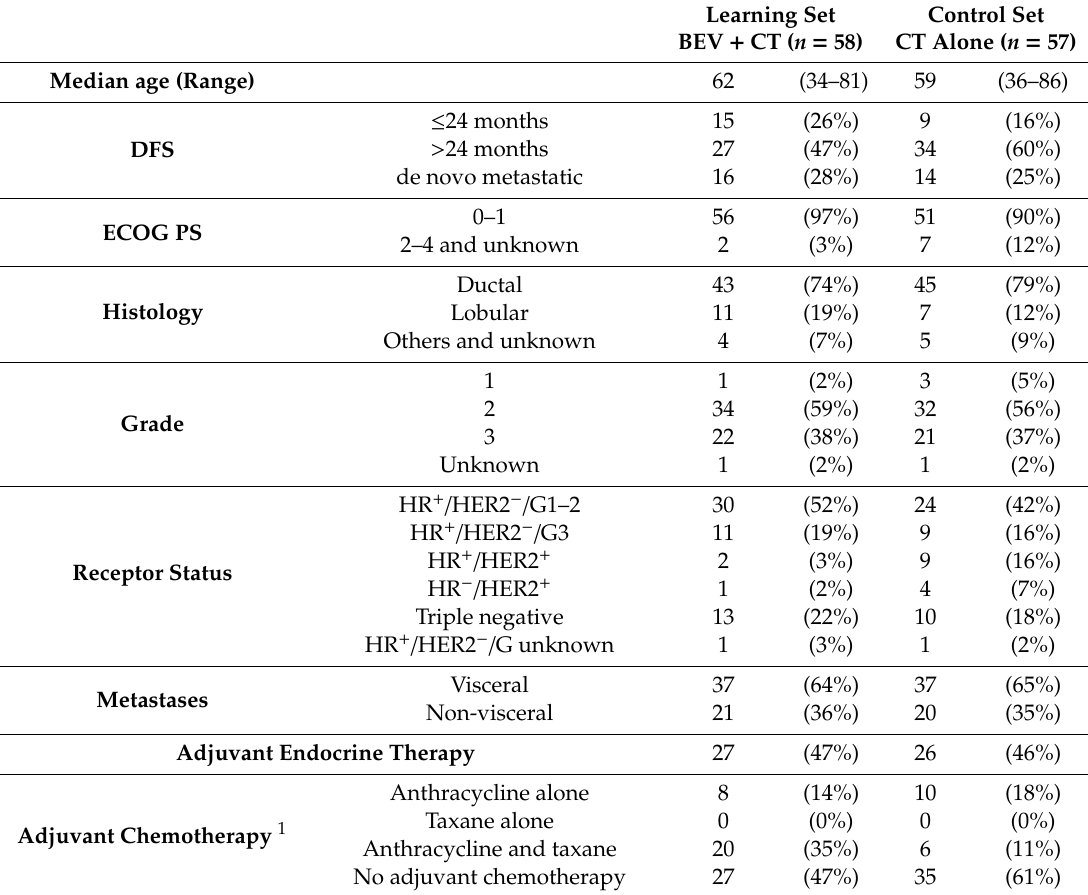
Table 1. Patient characteristics of the screening